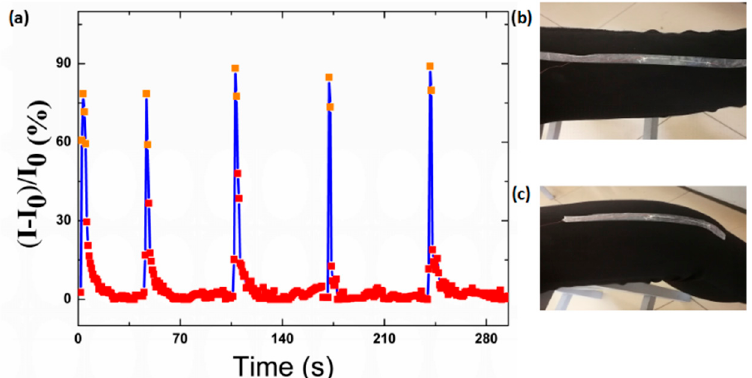
Figure 11. ( a ) Relative current change of the strain sensor in monitoring the bending of the knee. ( b ) Photograph of the knee in the original state. ( c ) Photograph of the knee in the bending state.